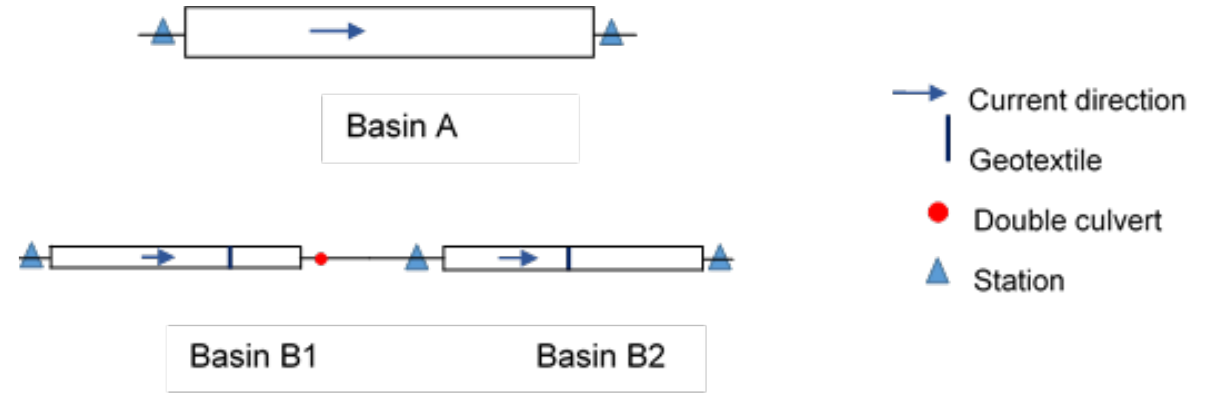
Figure 1. Diagram of the three basins studied, with the positions of water and sediment retention structures and stations. For dimensions and other characteristics of the basins, see Table 1 and Table A1